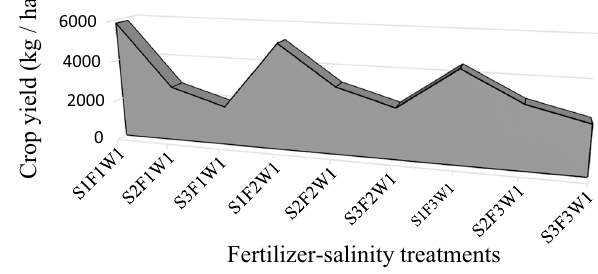
Fig. 10 Basil yield in kilograms per hectare (dry leaves) as a function of irrigation water and fertilizer consumption using real data in the studied farm